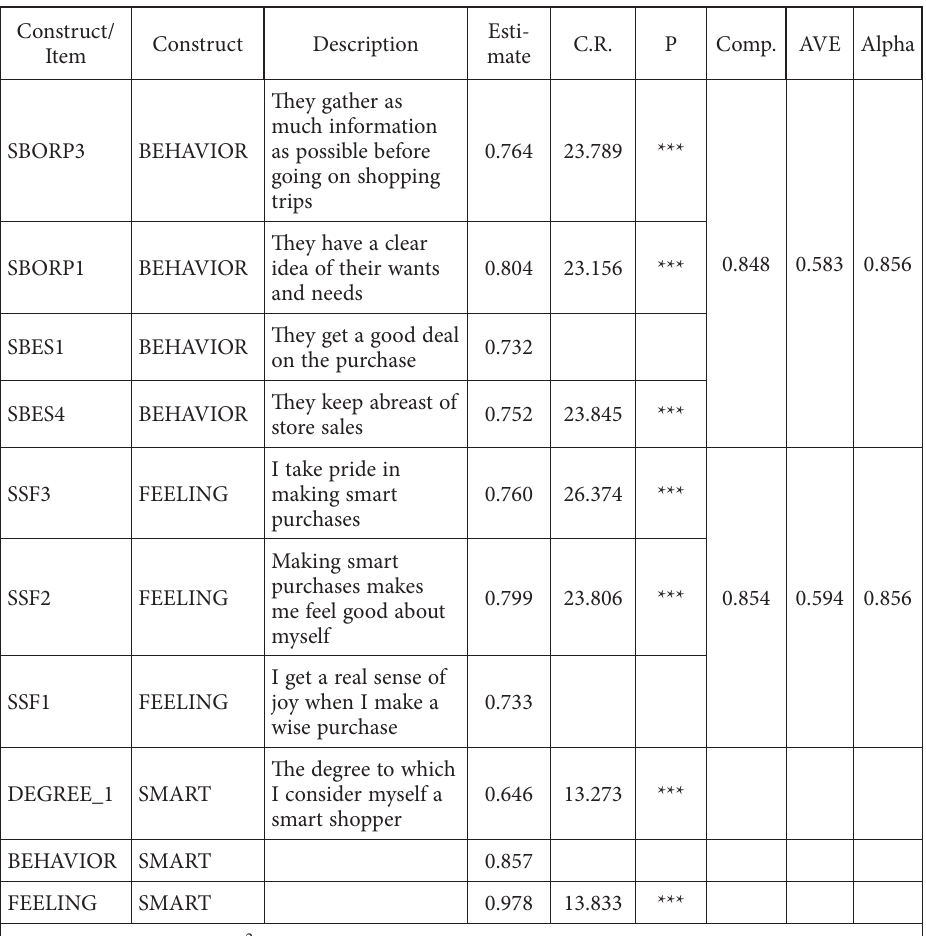
Table 5. Smart shopping second-order